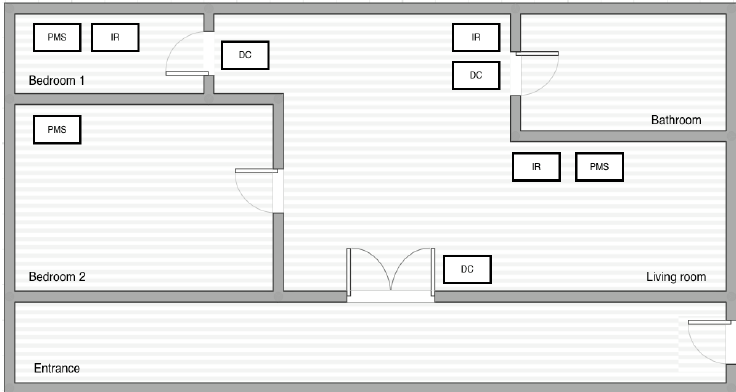
Figure 9. The floor plan of the Aruba dataset [48].